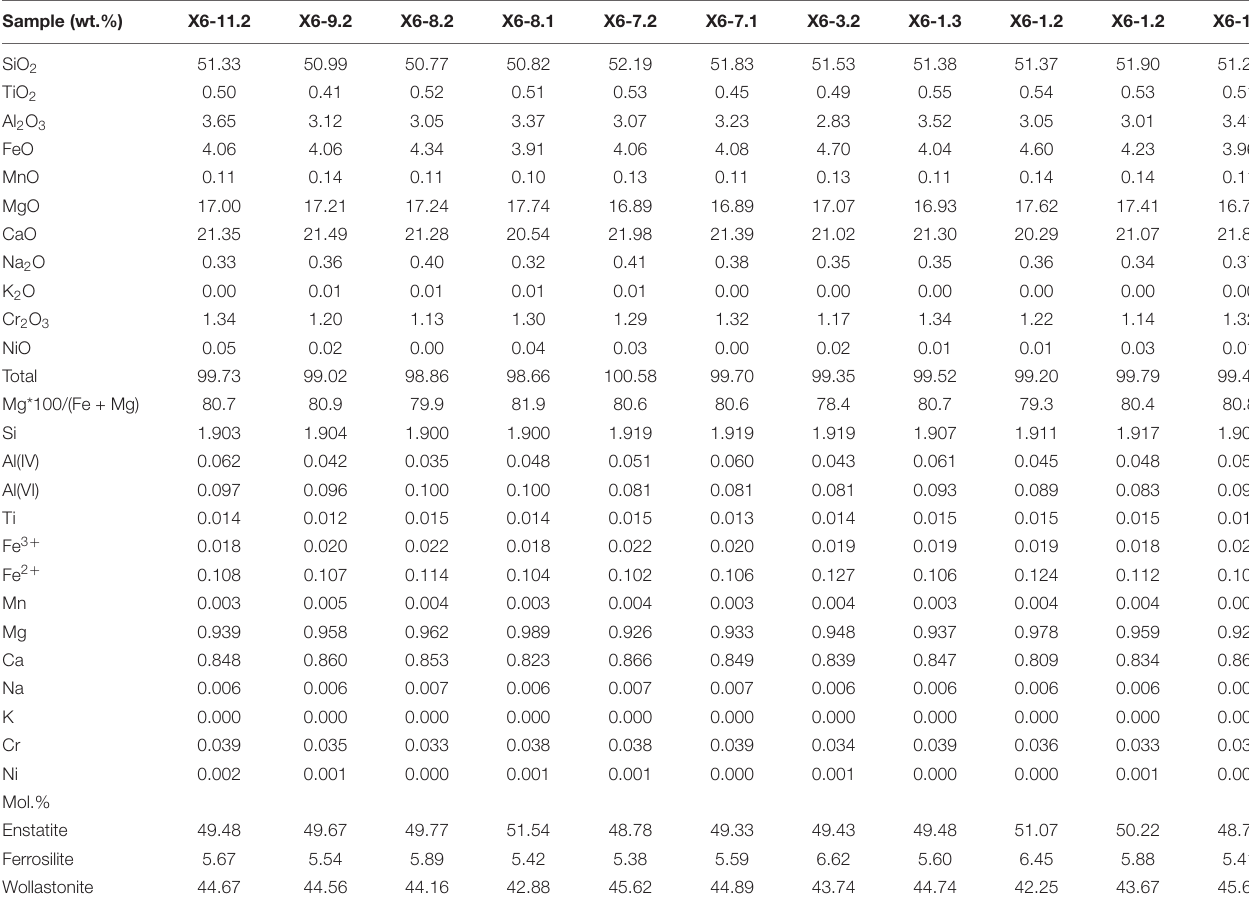
TABLE 4 | The composition of microprobe analysis of pyroxene in olivine gabbro from the Xiwanggou deposit. Sample